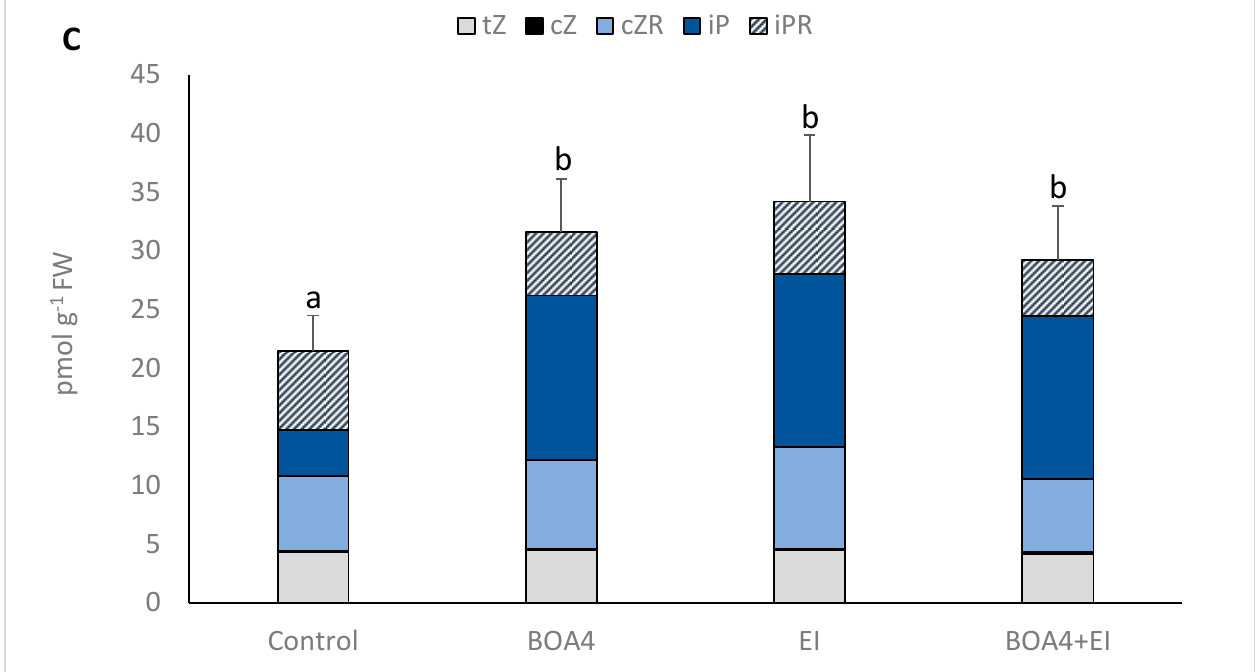
Figure 3. Shoot hormone content in salinized tomato. The hormones were quantified in shoots of plants grown in a greenhouse for 50 days. Identified bioactive cytokinins trans-zeatin (tZ), cis-zeatin (cZ), cis-zeatin-riboside (cZR), and cZ plus cZR are represented in panel ( A ). The smaller chart within panel (A) has a different Y-scale for better visualization of cZ content. Isopentenyladenine (iP) and the corresponding riboside, isopentenyladenosine (iPR), and iP plus iPR are represented in ( B ). Total and relative cytokinin contents for each treatment are represented in ( C ). BOA4: Achromobacter xylosoxidans strain BOA4; EI: Enteromorpha intestinalis extract; BOA4 + EI: Achromobacter xylosoxidans strain BOA4 plus Enteromorpha intestinalis extract. Different letters above the bars indicate means that differ significantly ( p < 0.05).